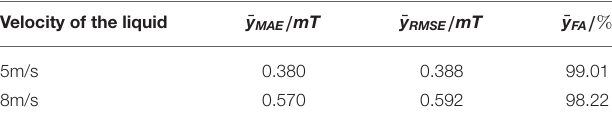
TABLE 5 | Error and precision comparison of predicted